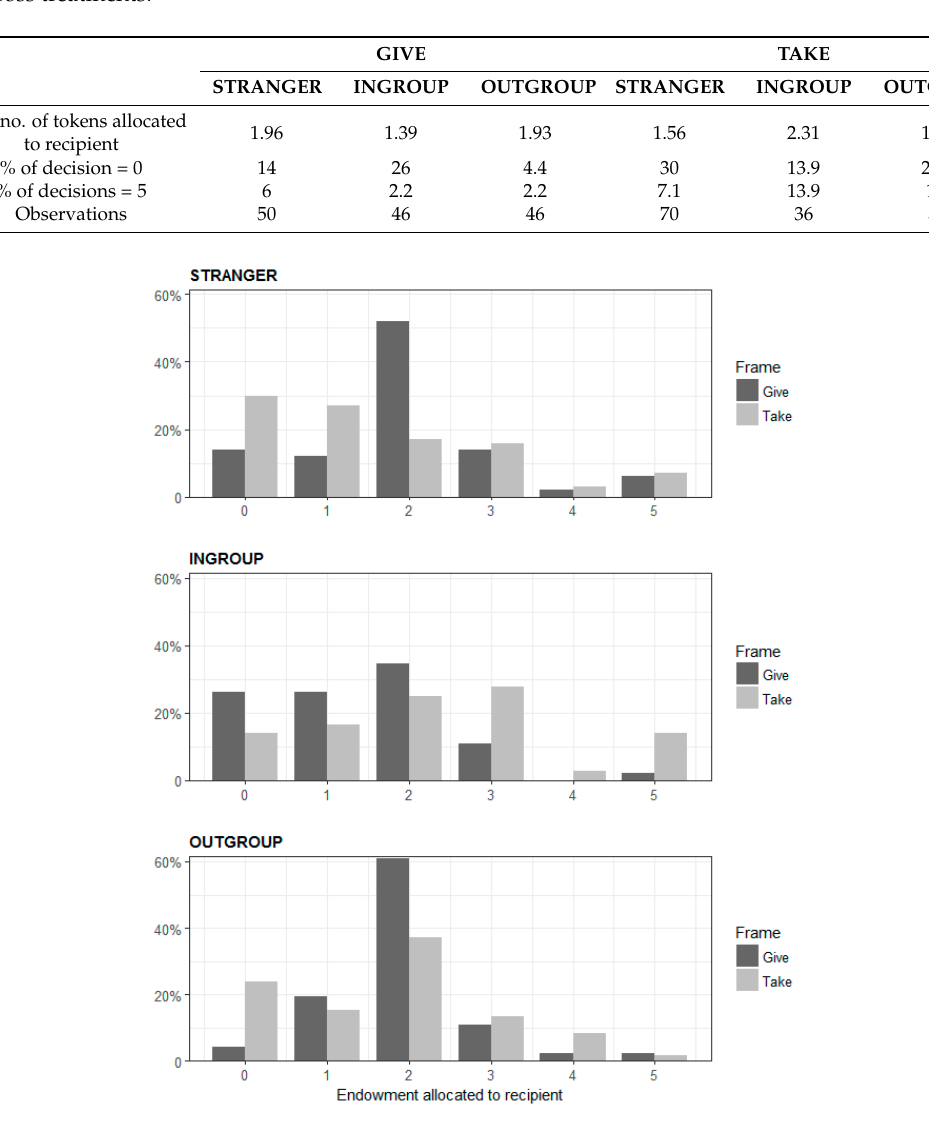
Figure 1. Treatments compared within groups.